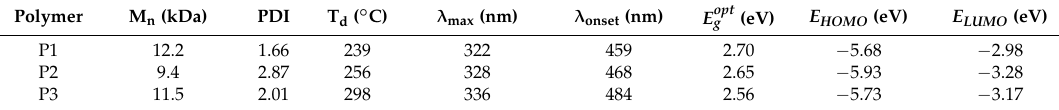
Table 1. Optical, thermal and electrochemical properties of P1, P2 and P3.